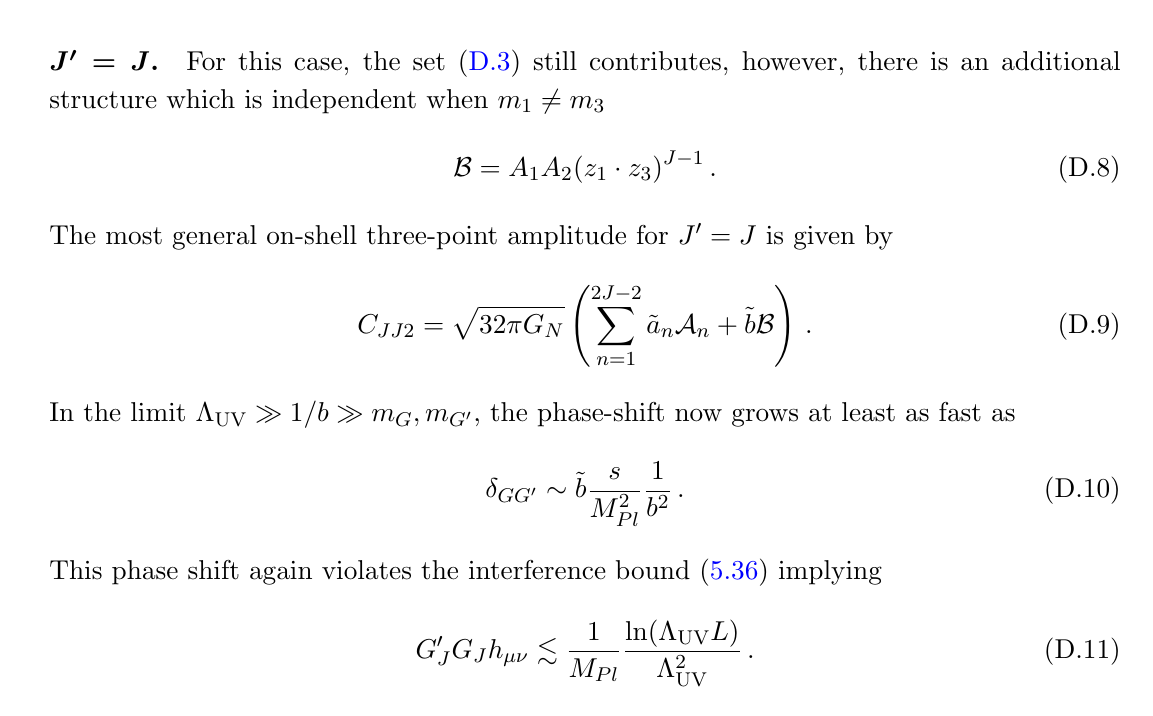
is obtained from this